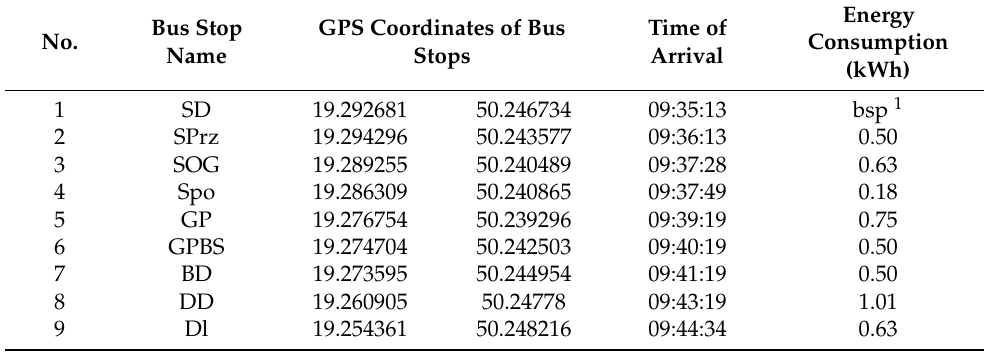
Table 1. Bus journey parameters.